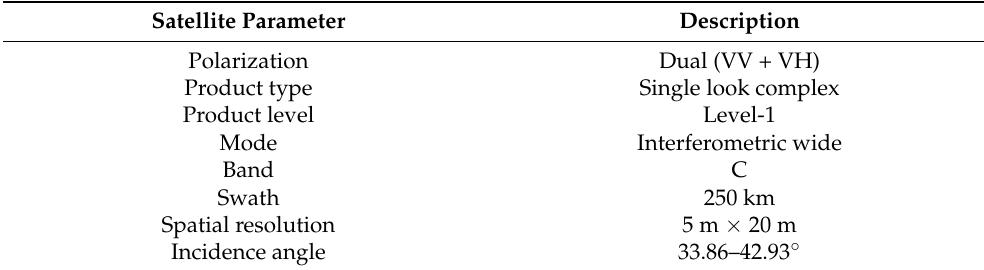
Table 1. The basic details of the Sentinel-1 imagery.